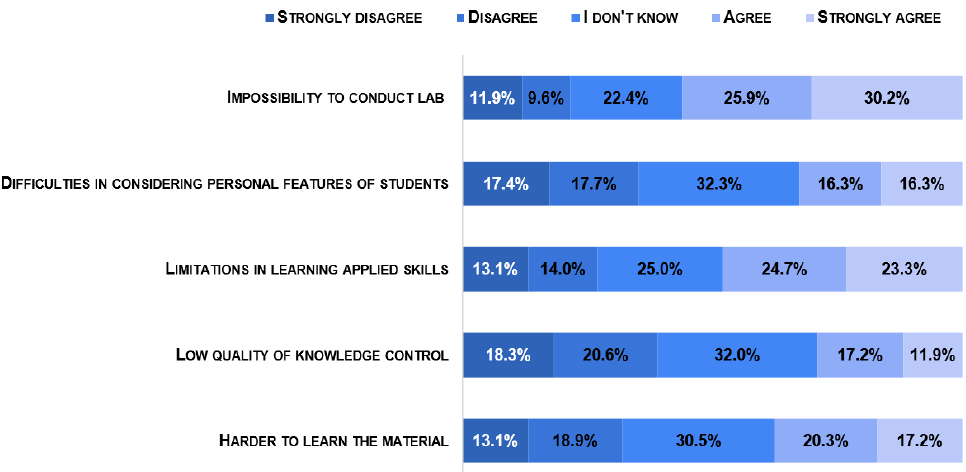
Figure 8. Methods for mastering educational materials. The majority of students agree with the statement that modern education should combine distance technologies and traditional educational practices (68.9%), and the skills acquired in the distance learning format will be useful to them in their future professional activities (57.8%). In general, 65.7% of the students who took part in the study confirmed their positive attitude towards the distance format: almost 58% noted positive changes in their ability to learn independently, 52.9% mentioned an increase in the quality of